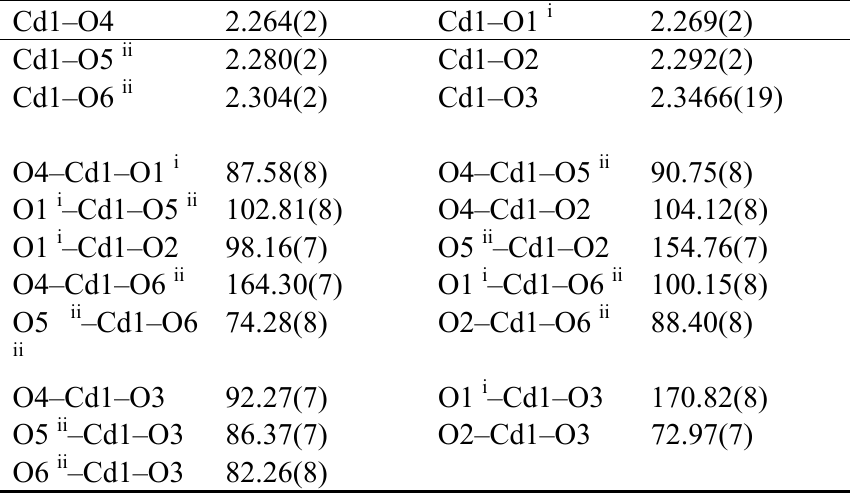
Table 1. Selected geometrical data (Å,  ) for 1